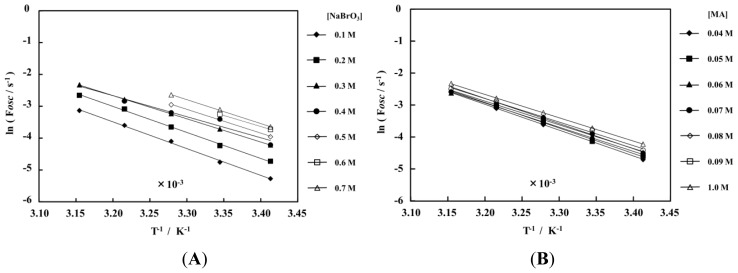
Arrenius dependence on temperature of oscillating frequency, Fosc, under fixed concentrations of the other two BZ substrates: (A) [MA] = 0.1 M and [HNO3] = 0.3 M; (B) [NaBrO3] = 0.3 M and [HNO3] = 0.3 M; (C) [NaBrO3] = 0.3 M and [MA] = 0.1 M. (D) Dependence of activation energy on concentrations of three BZ substrates.